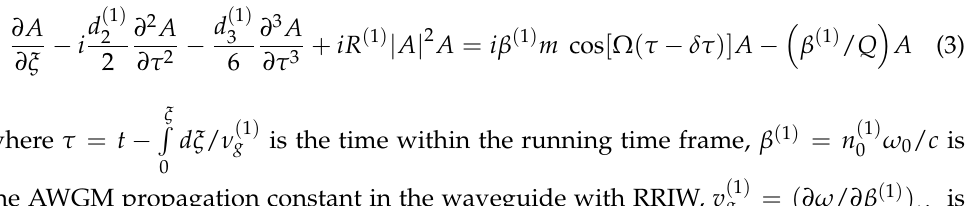
V V , and V are the ve- z x